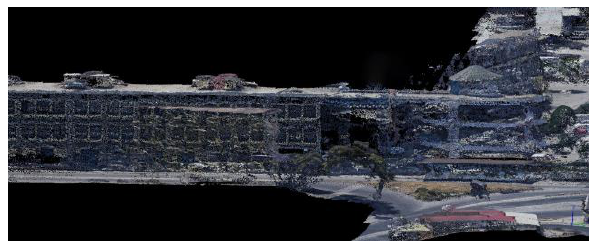
Figure 4 . Point cloud obtained in Metashape with Insta360 camera. Detail.